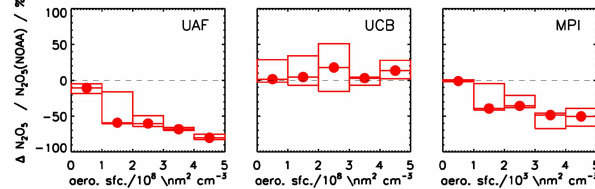
Fig. 6. Statistical analysis of the relative difference of N 2 O 5 measurements between UAF-CRDS, MPI-CRDS, UCB-LIF instru- ments and NOAA-CRDS depending on the aerosol surface concen- tration during the experiment on 15 June, when ammonium sulfate aerosol was injected into the chamber. Dots are medians and boxes give the 25 to 75 percentiles of the distribution. Fig. 7. Comparison of measured N 2 O 5 mixing ratios to calculations